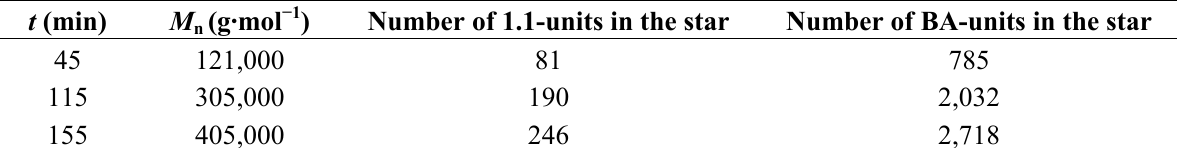
Table 2. Determined numbers of BA- and 1.1 -units in different polymer samples of a